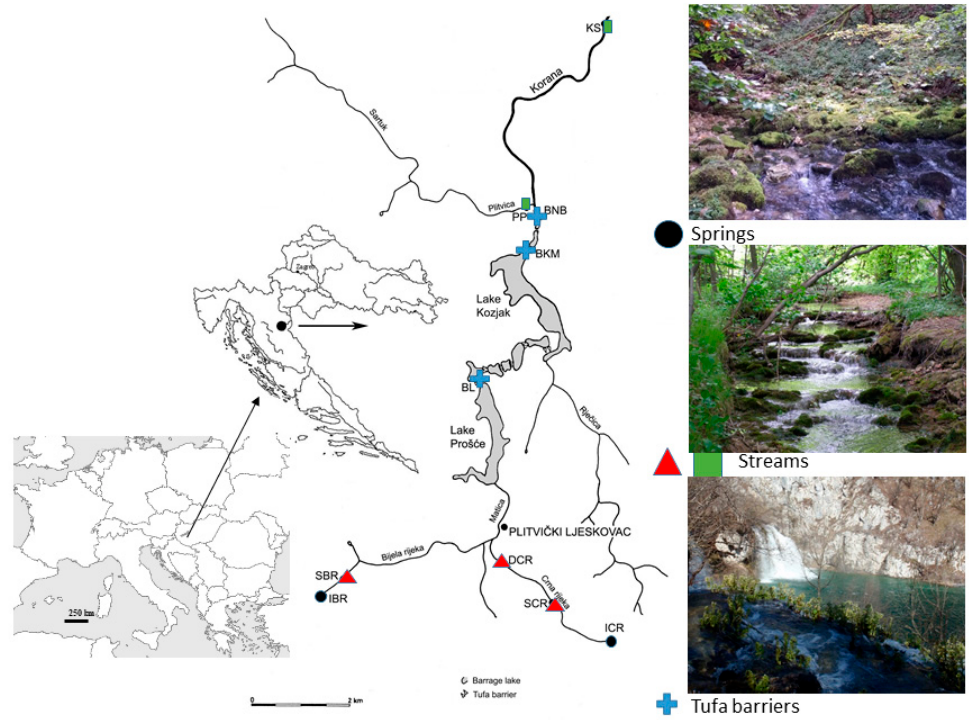
Figure 1. Map of the study area (Plitvice Lakes NP, Croatia) with the locations of the ten sampling sites. Abbreviations of the sampling sites and main site characteristics are presented in Table 1. Springs— black circle ; Upper stream reaches— red triangle ; Tufa barriers— blue cross ; Lower stream reaches— green rectangle . Table 1. Characteristics of the sampling sites in the Plitvice Lakes NP. IBR—Spring of Bijela rijeka, SBR—Upper reach of Bijela rijeka, ICR—Spring of Crna rijeka, SCR—Upper reach of Crna rijeka,